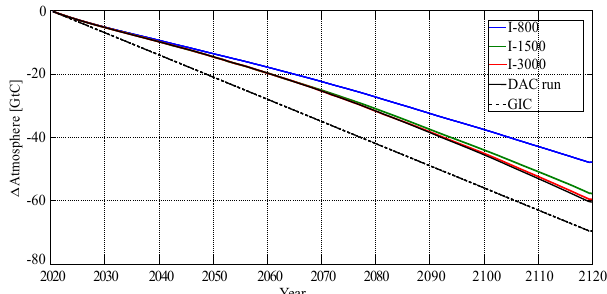
Figure 3. Absolute change in atmospheric carbon in the Direct Air Capture run (DAC) and in the With Emissions simulations, relative to the RCP 8.5 control run. The black dashed line denotes the glob- ally injected carbon (GIC), which is subtracted from the emission forcing (see Sect.